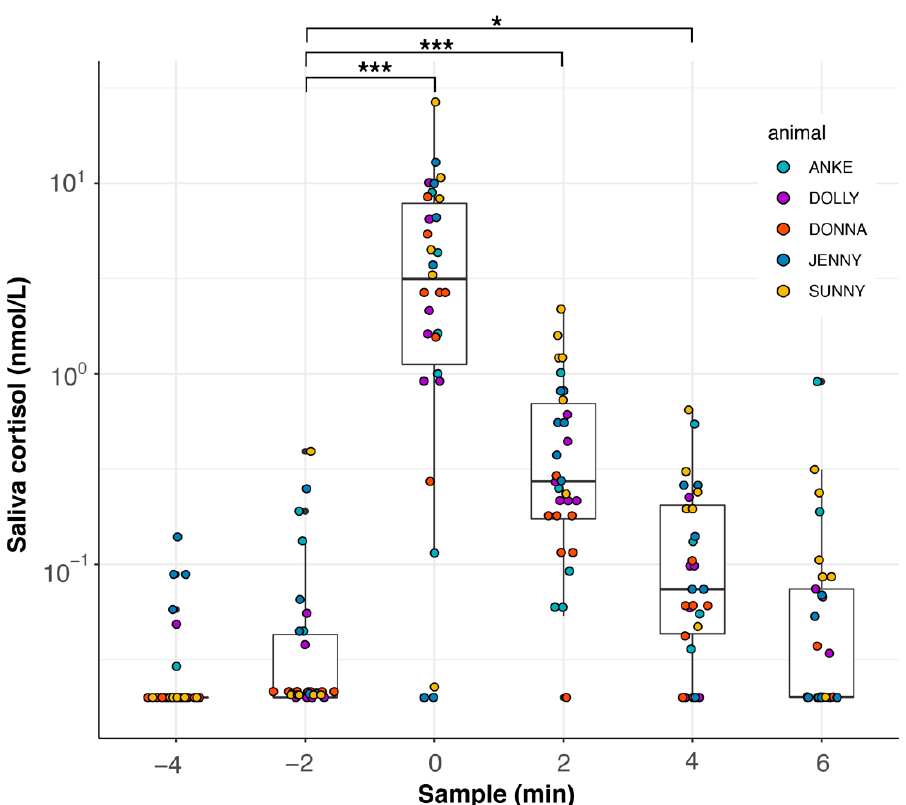
Figure 9. Saliva cortisol values during feeding experiment II. Saliva samples were taken every two minutes over a course of 10 min. At minute 0, dolphins were fed with fish (capelin, Mallotus villosus ) and a saliva sample was taken directly afterwards. The experiment was conducted with 5 female dolphins and repeated 5–7 times (Anke, 5 times; Dolly, Jenny, and Sunny, 6 times; Donna, 7 times). Some selected significance levels of Tukey’s pairwise post hoc comparisons are indicated as